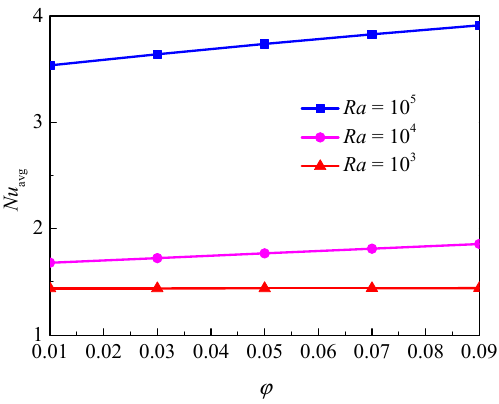
Figure 5. Average Nusselt number ( Nu avg ) of the inner wall for different nanoparticle volume fractions ( φ ) and Rayleigh numbers ( Ra ) at Da = 10 − 2 , d sp = 50 nm, ε = 0.5, and RR = 2.